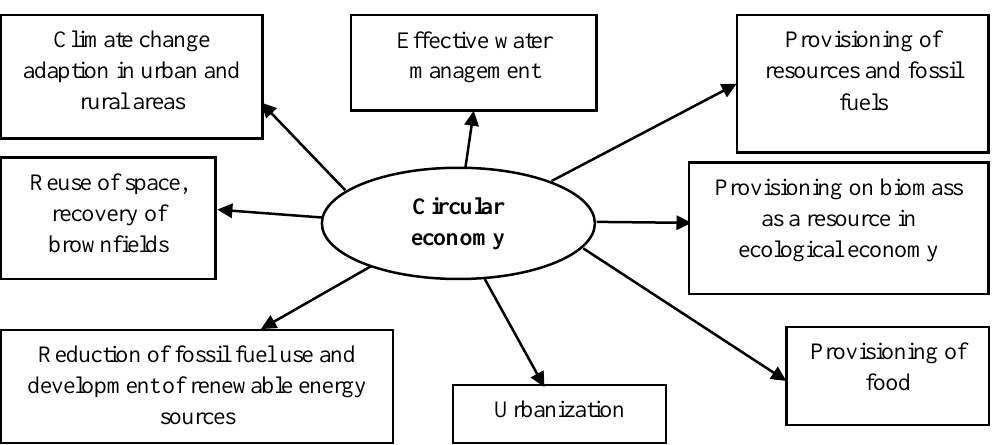
Fig. 3. Societal issues solved using circular economy (made by the authors).